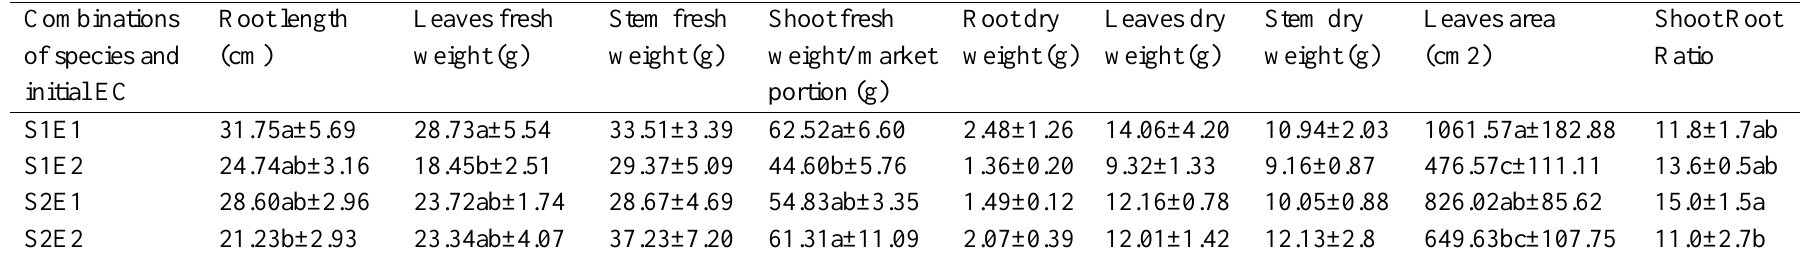
Table 13. Effect of combination of species and initial electrical conductivity on root length, leaves fresh weight, stem fresh weight, shoot fresh weight (market portion), root dry weight, leaves dry weight, stem dry weight and leaves